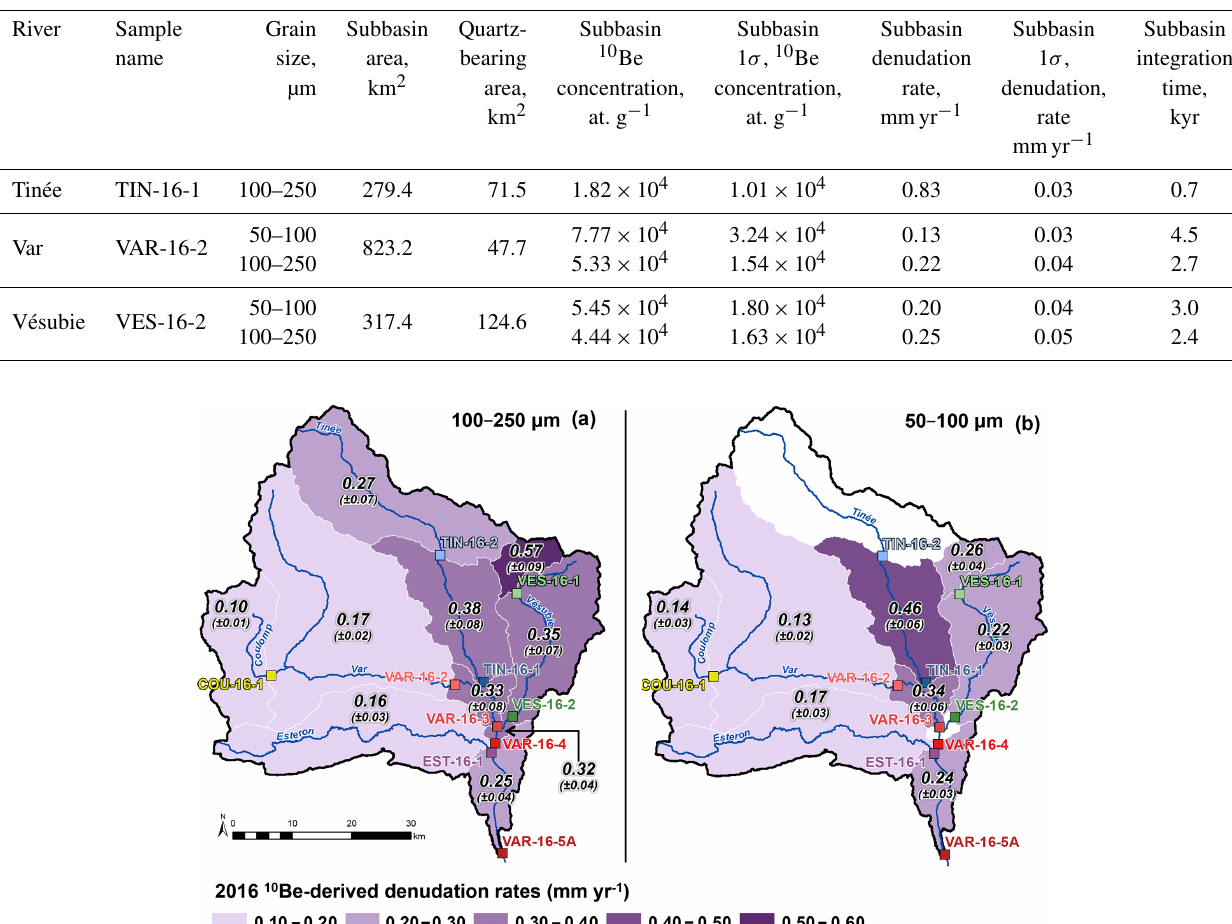
Figure 3. Spatial variations in 10 Be-derived denudation rates for the 2016 Var samples (data reported in Table 1). White polygons denote the absence of data. Denudation rates were derived from the (a) 100–250µm and (b) 50–100µm grain-size